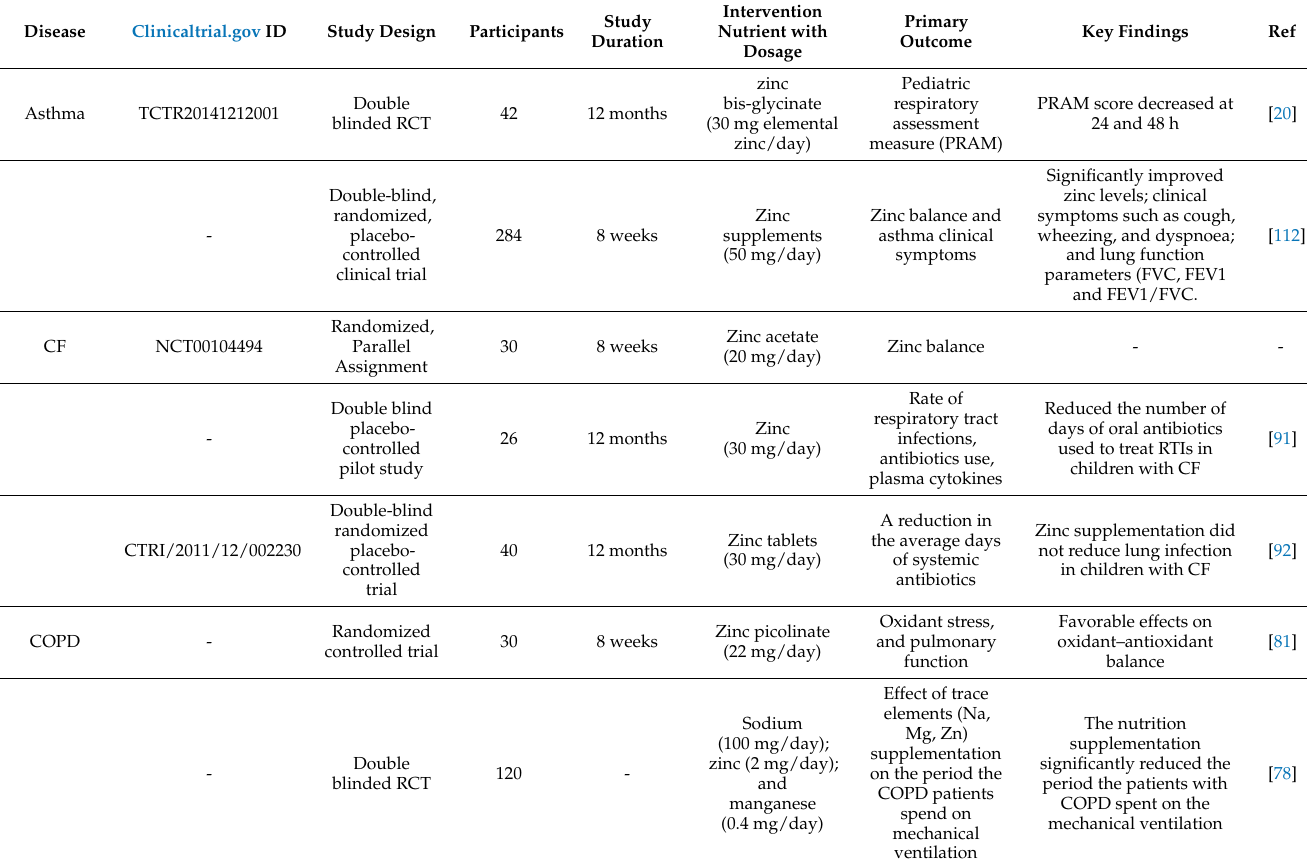
Table 2. Clinical trials that study zinc supplementation in lung